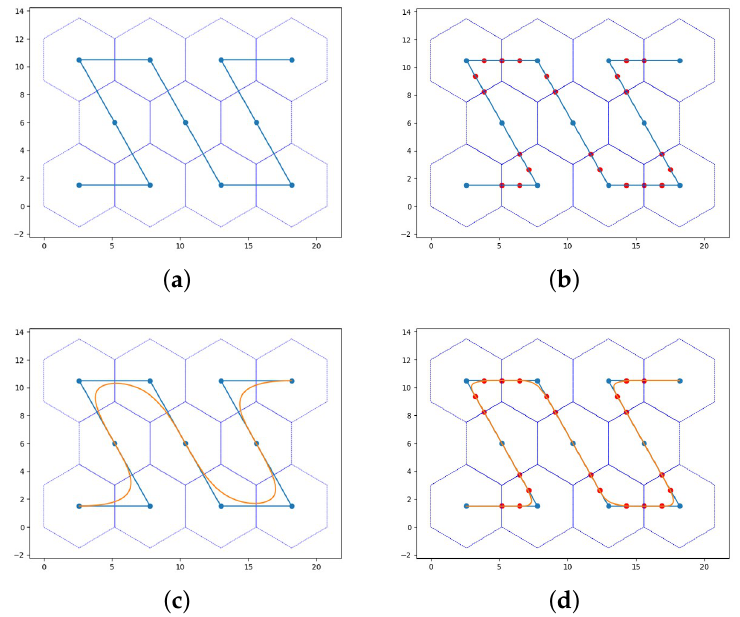
Figure 5. Supplementary waypoint interpolation. ( a ) Raw waypoint. ( b ) Supplementary Interpolated Post Waypoints. ( c ) Raw Waypoint Curve Fitting. ( d ) Waypoint curve fitting after supplementary